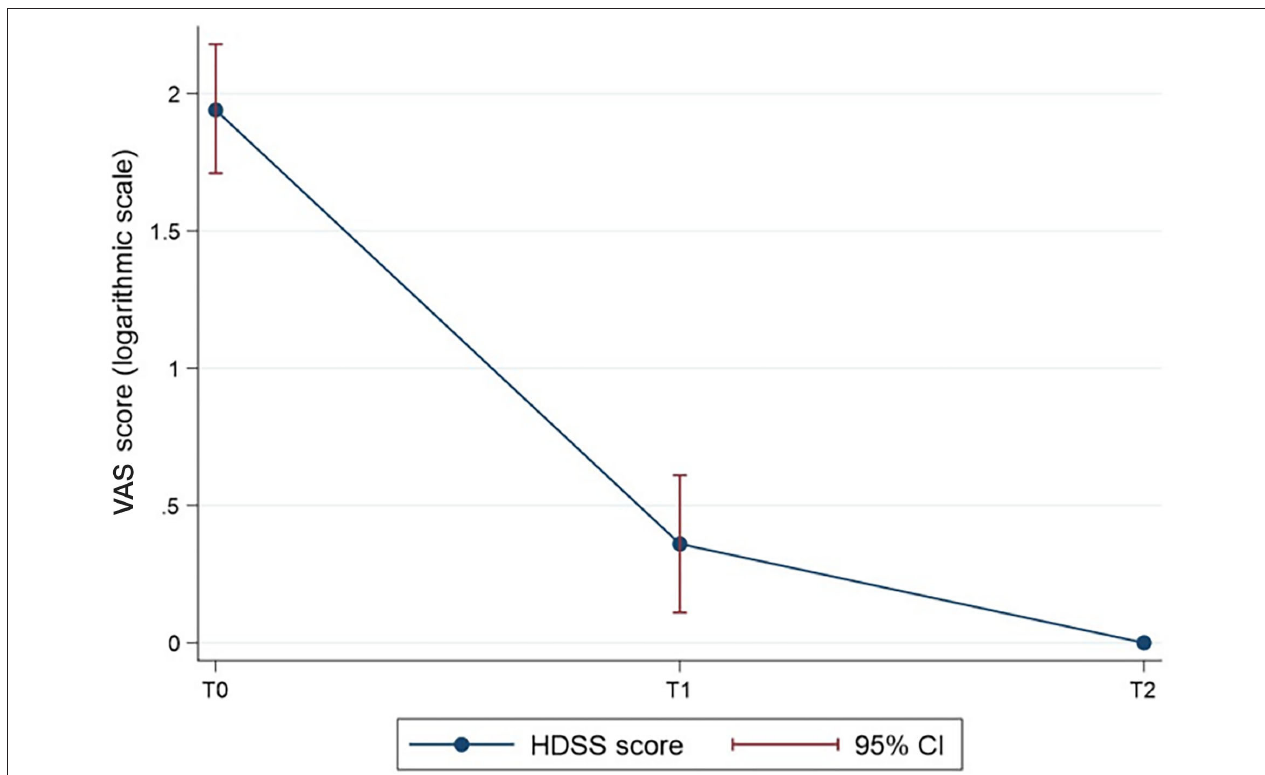
FIGURE 1 | The HDSS score over time (log-transformed for normalisation of the VAS score data). P < 0.001 for T1 vs. T0 and T2 vs. T0.